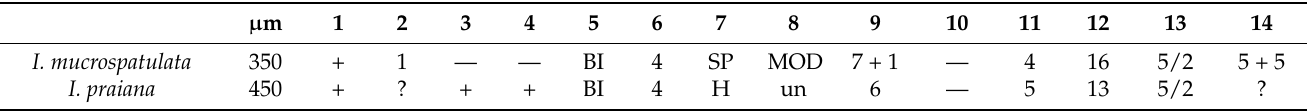
Table 10. Morphological characters of Isotogastrura species record from Brazil modified from [34]; 1, Abd V tegumentary tubercle; 2. Abd I sternite chaetae number; 3. Abd III tergite with a pair of tubercles; 4. Prelabral chaetae (presence vs. absence); 5. Sensillum of Ant III simple or bifid; 6. Dental chaetae; 7. Shape of mucro; 8. Genital chaetae; 9. Number of sensilla on Ant IV; 10. Tubercles on Abd VI; 11. Chaetae on labial triangle; 12. Chaetae on manubrium; 13. Chaetae on furcal subcoxa; 14. Basal manubrium Chaetae. Abbreviations: BI = bifid; H = hooked; MOD = modified; SP = spatulate; un = unmodified; “?”—missing